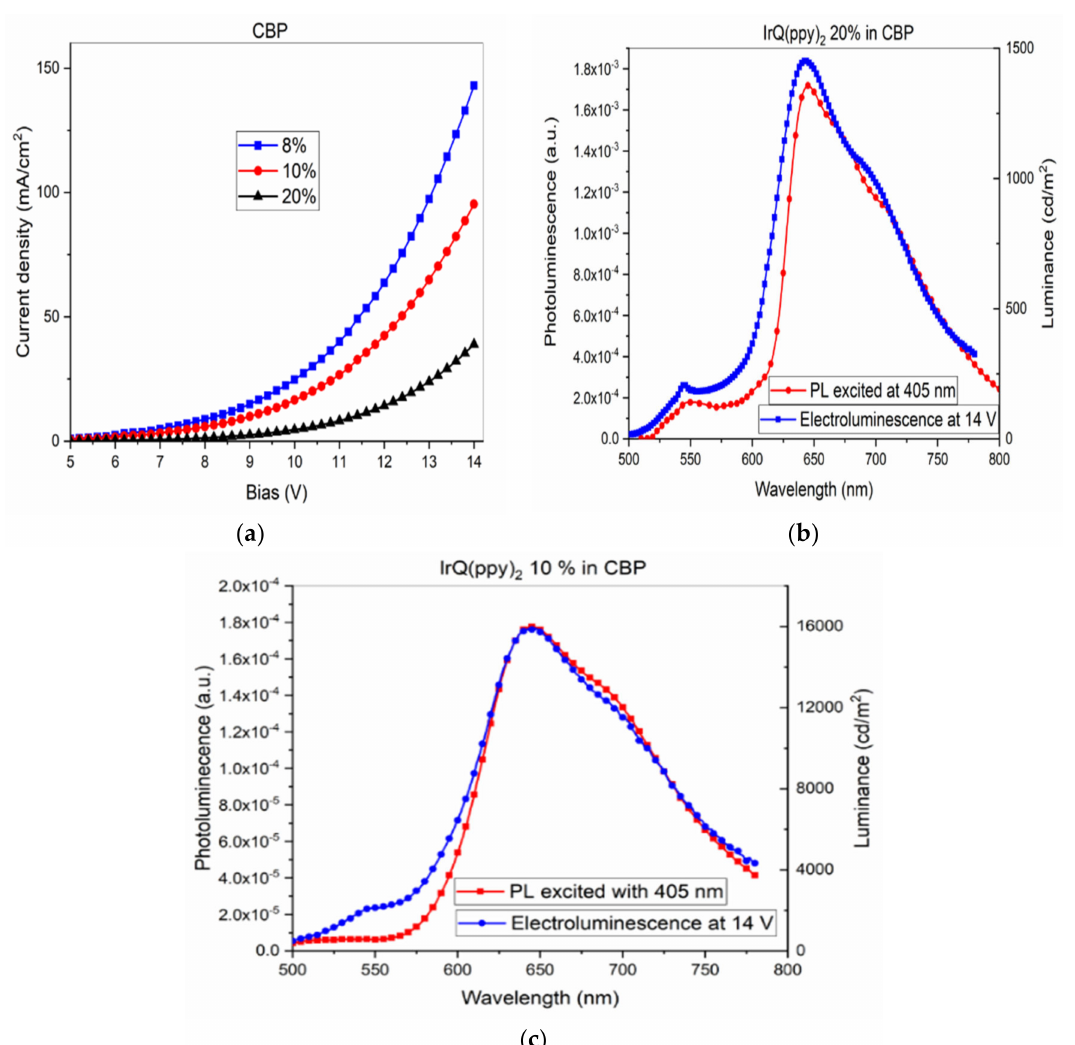
Figure 5. ( a ). Current–voltage of IrQ(ppy) 2 based OLED in CBP versus concentrations; ( b ) luminance and photoluminescence of the IrQ(ppy) 2 (20%) in CBP. ( c ) Luminance and photoluminescence of the IrQ(ppy) 2 (10%) in